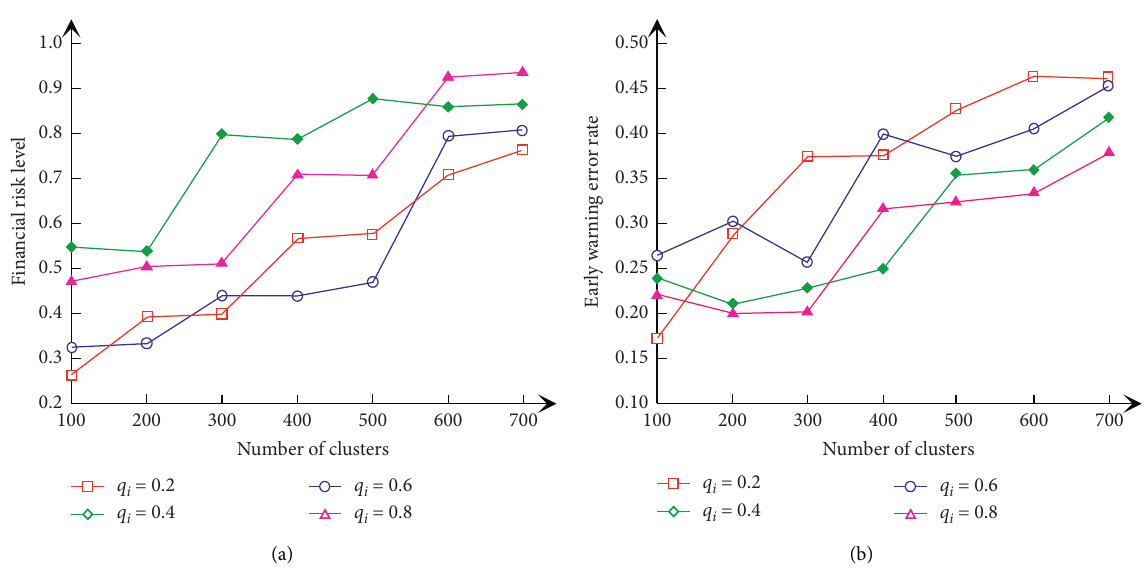
Figure 4: Financial risk levels (a) and early-warning error rate (b) at different number of clusters when financial risk early-warning indicator qi is 0.2, 0.4, 0.6, and 0.8,